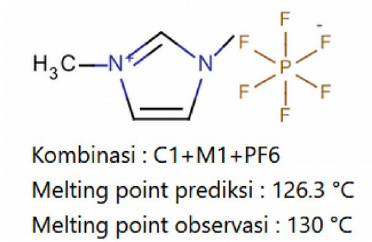
Figure 2. Designing an ionic liquid